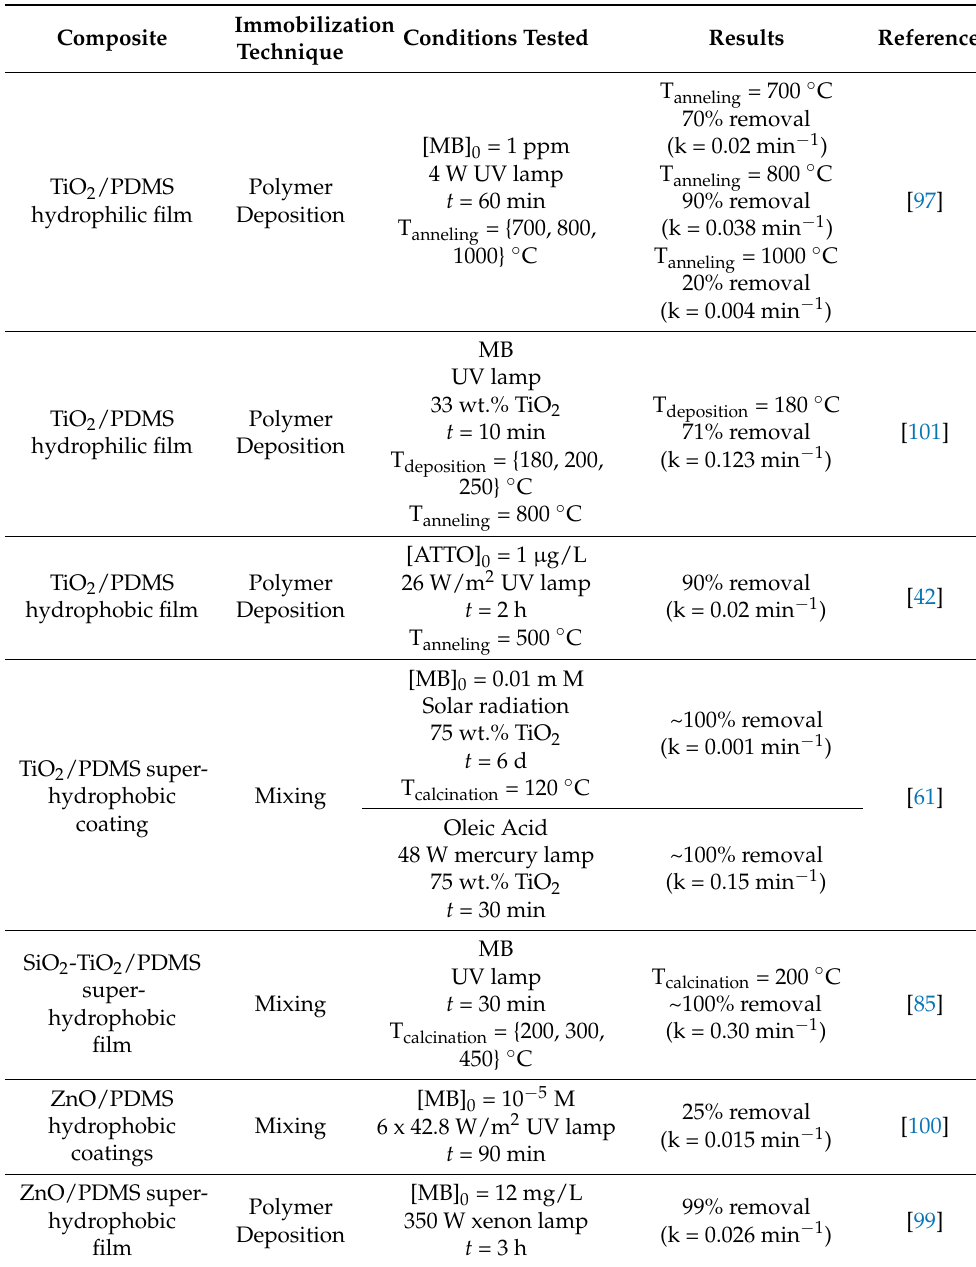
Table 14. Temperature effect on the hydrophobicity/hydrophilicity of PDMS membranes and on the kinetic rate of the PDMS-supported photocatalysis